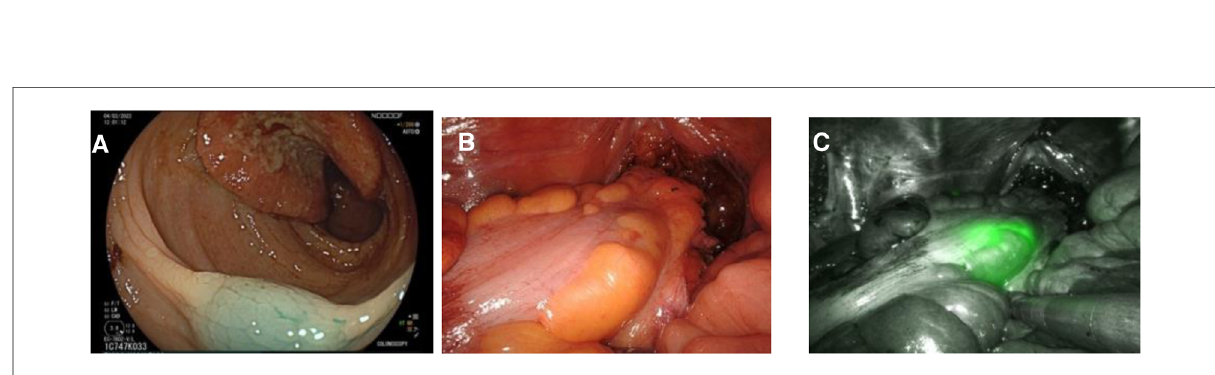
FIGURE 2 Three images of the same patient marked with indocyanine green. ( A ) Endoscopic view of marked tissue with Indocyanine Green . ( B ) Intraoperative view of rectosigmoid junction during robotic surgery under white light. ( C ) Intraoperative view of rectosigmoid junction during robotic surgery under Near-Infrared visualization